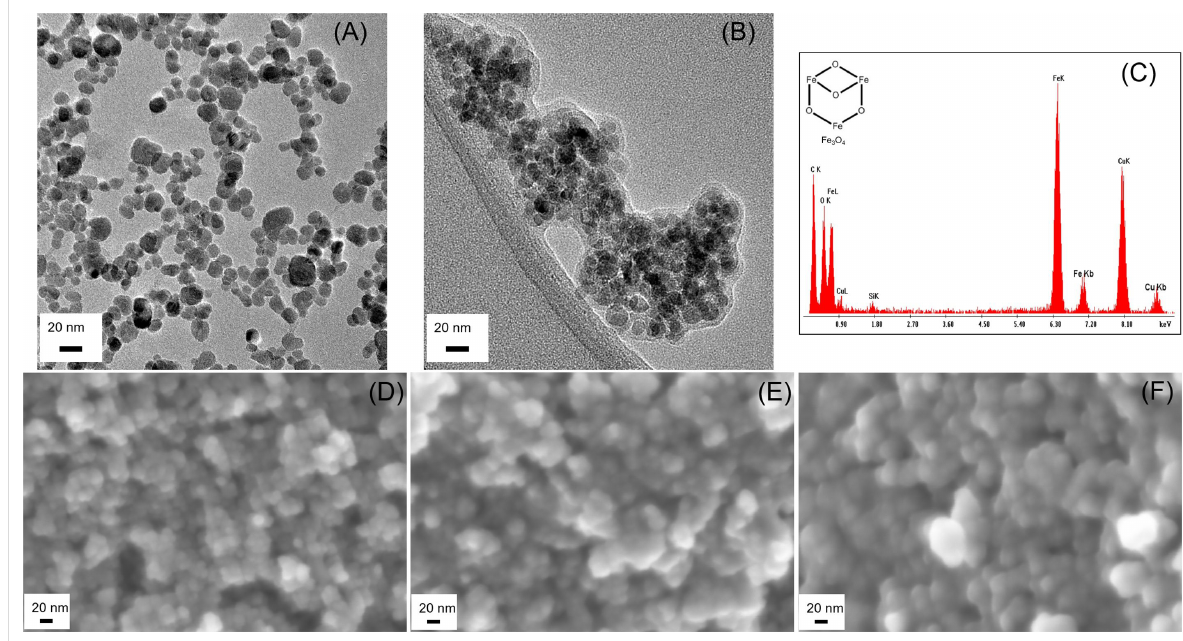
Figure 3: TEM images of uncoated SPIOs (A), PEG-SPIOs (B) with scale bar of 20 nm. EDS spectrum of uncoated SPIOs (Fe 3 O 4 ) (C). SEM images of uncoated SPIOs (D), PEG-SPIOs (E), and IPC-SPIOs with PEG and polygallol (F). PEG-SPIOs ( n = 66) and uncoated SPIOs ( n = 25) were measured to calculate the mean size of the particles and PEG coating thickness in the TEM images, respectively.